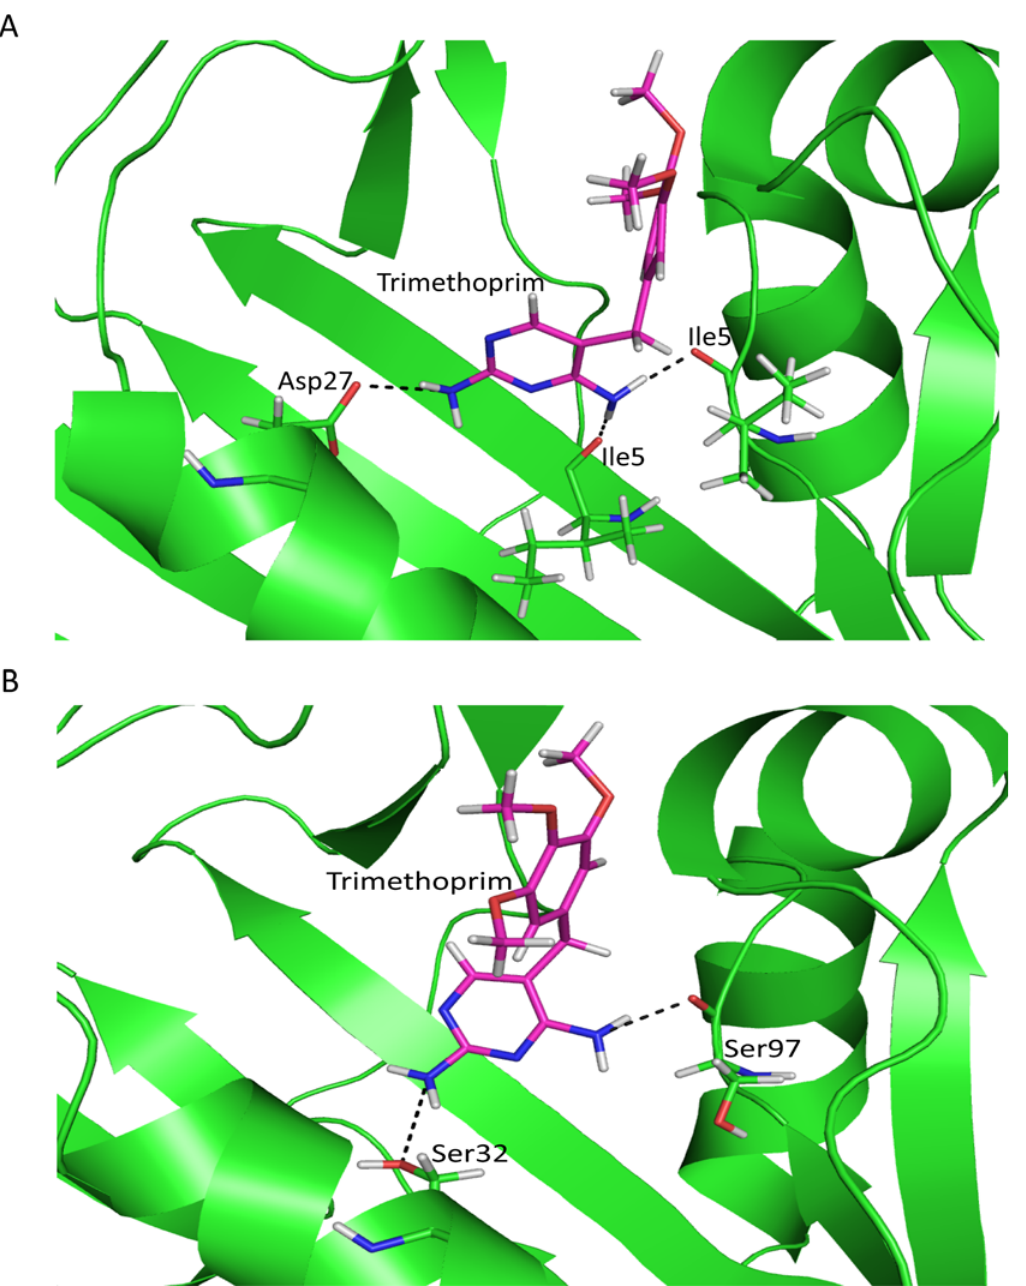
Fig 5. Hydrogen bonding between ligand and protein active site residues. Dash line shows hydrogen bond between, trimethoprim (magenta) and protein active site residues (green), A) TMP-sensitive-Dfr-TMP complex, B) PGB01-DfrA7-TMP